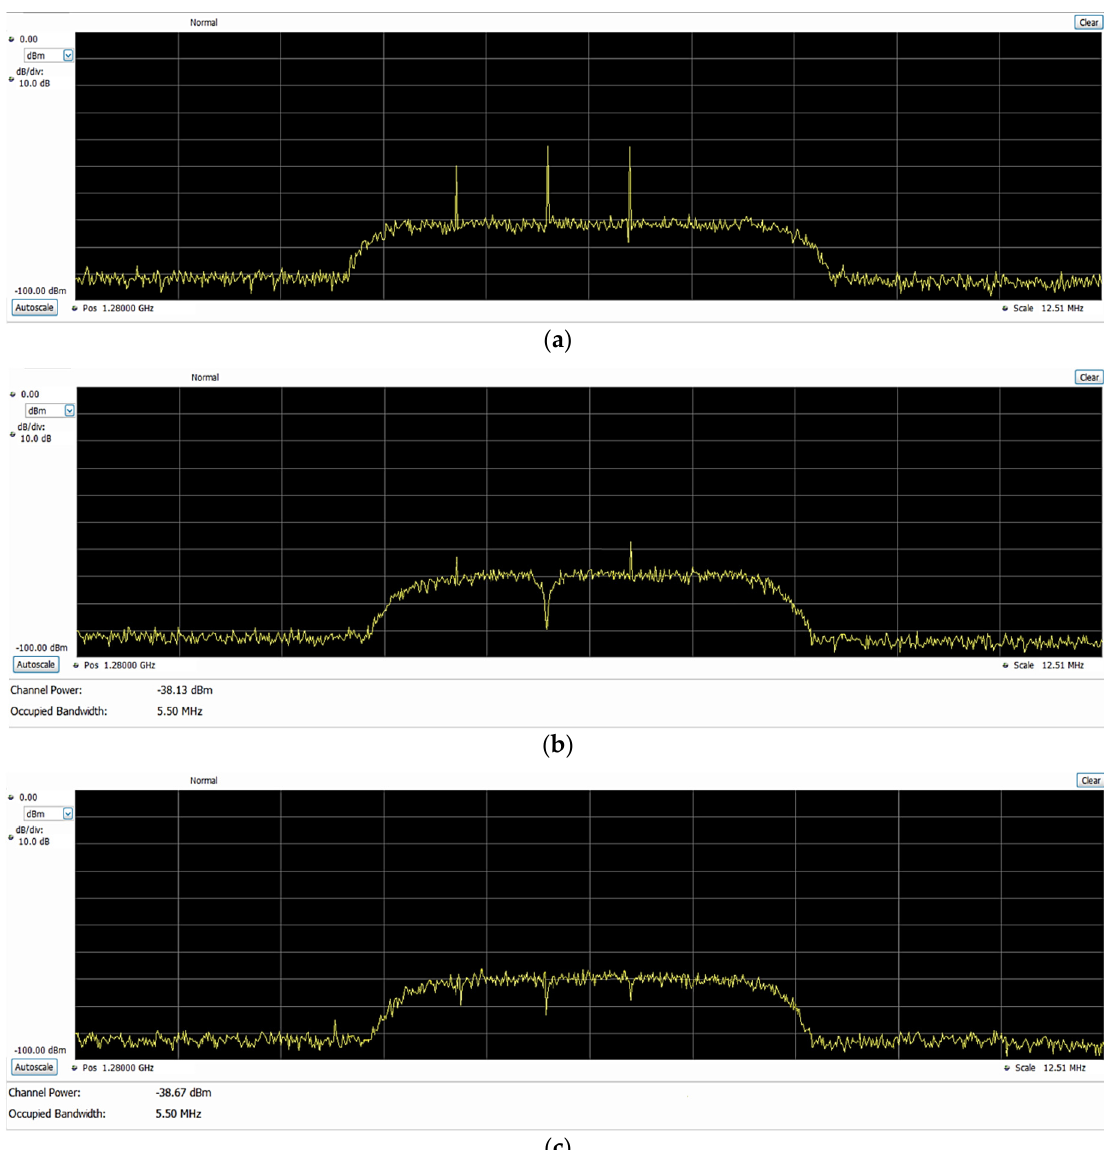
Figure 18. Example of MCWI on the power spectrum of the DVB-S2 signal represented by Techtronic; ( a ) three peaks of MCWI before filtering; ( b ) example of notch filtering with constant bandwidth; ( c ) spectrum enhancement by notch filtering with adaptive bandwidth.